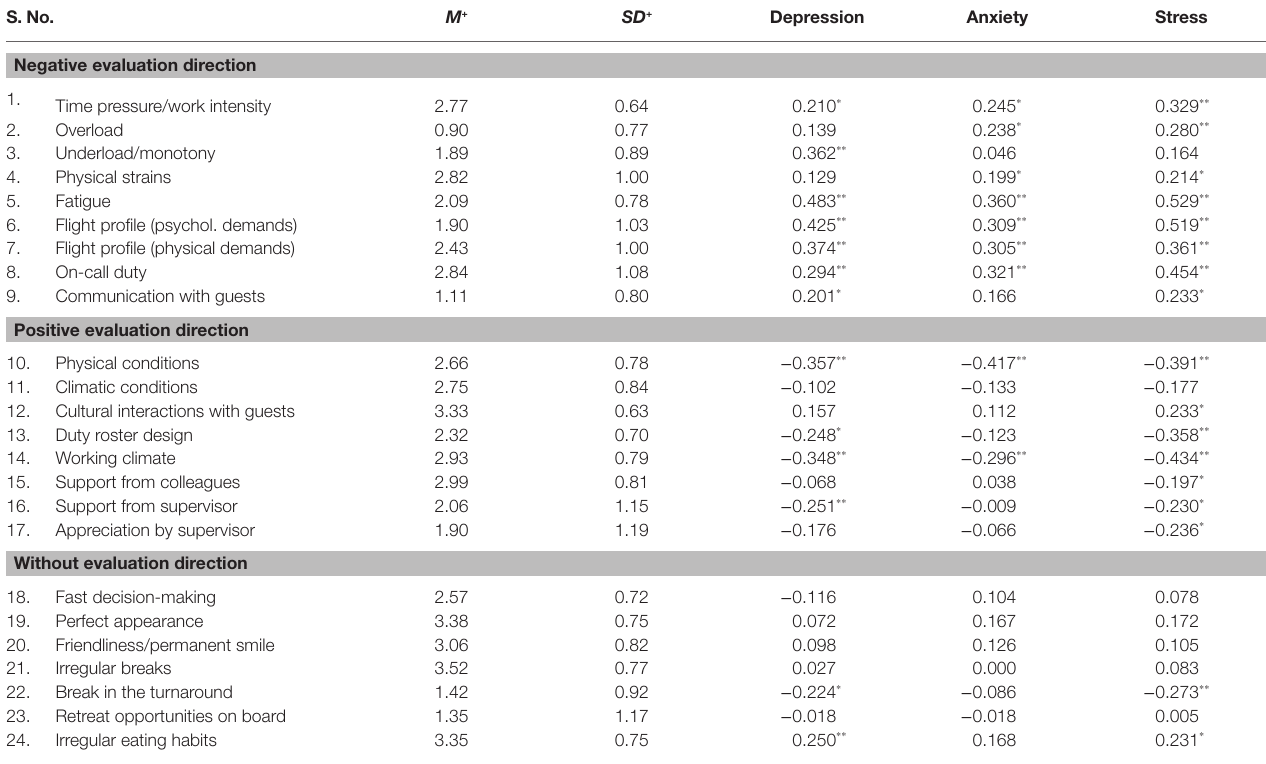
TABLE 3 | Correlations between conditional factors and DASS-scores, sample 1 May 2019. S. No. M + SD + Anxiety